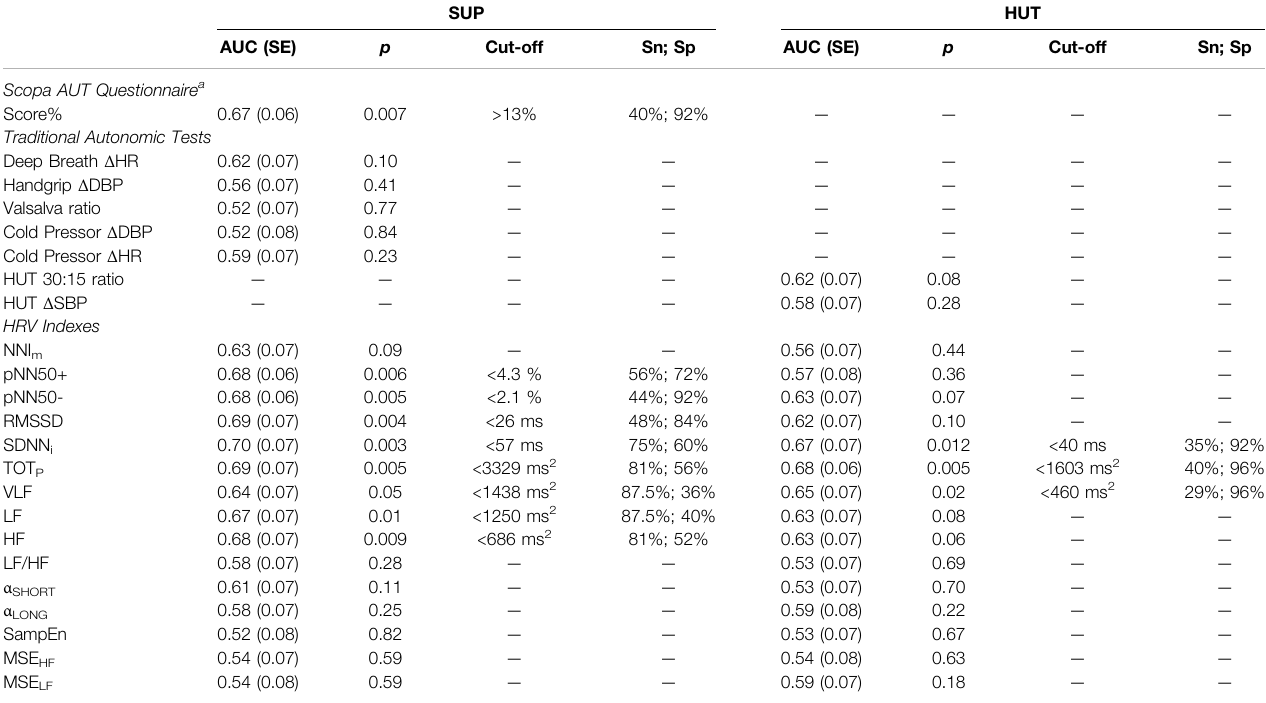
TABLE 3 | Area under the ROC curve (AUC) for the traditional autonomic tests and for HRV indexes by condition, with signi fi cance p, cut-off value, sensitivity and speci fi city for patients ’ identi fi cation. SUP HUT p Cut-off